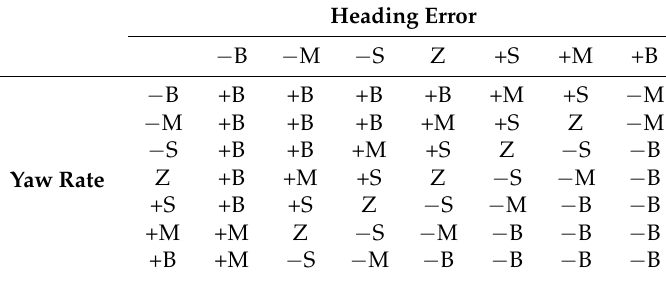
Table 5. The reasoning rules of heading